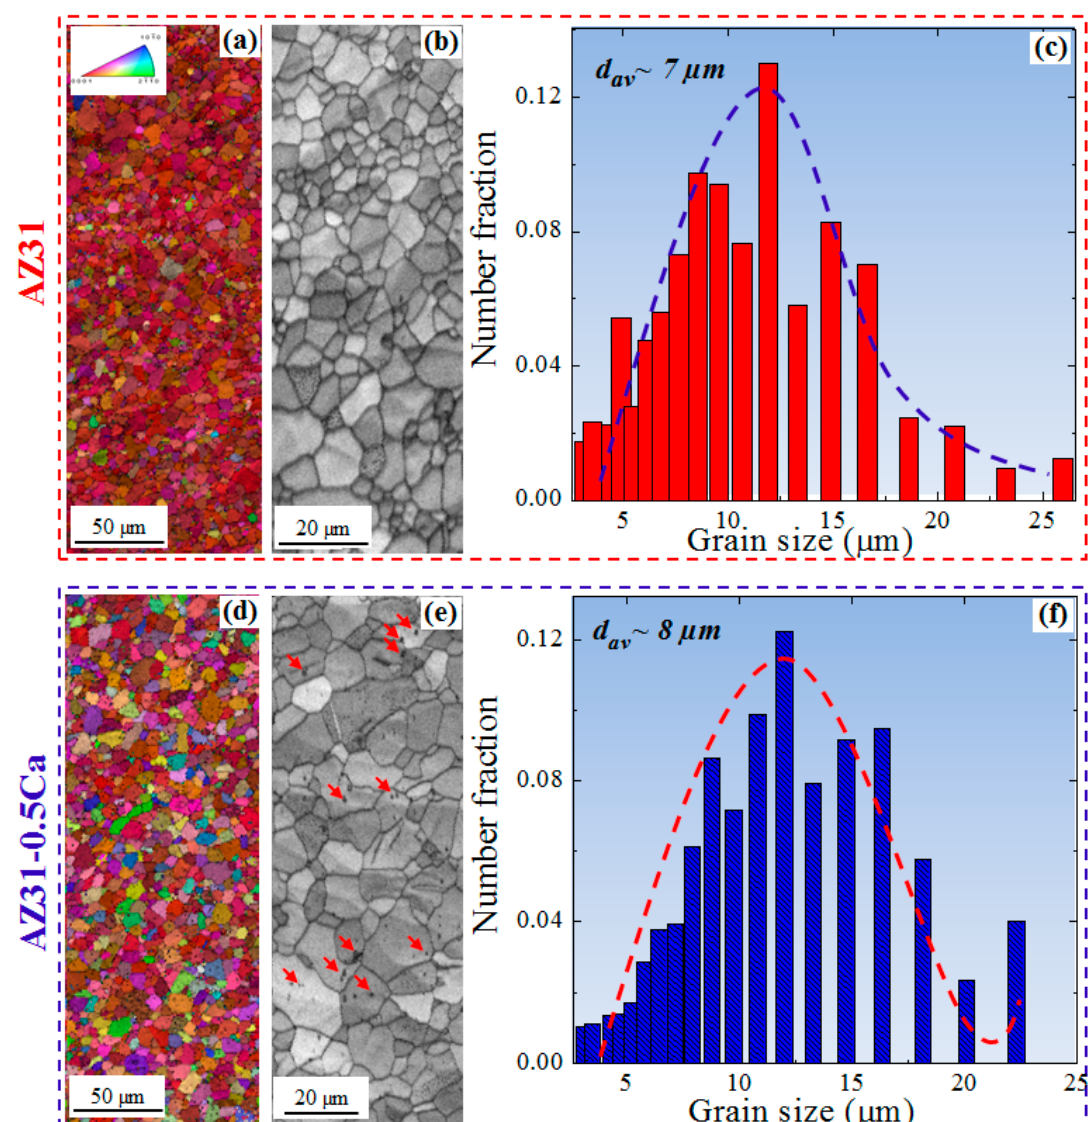
Figure 2. ( a , d ) ND inverse pole figure maps; ( b , e ) image quality maps; and ( c , f ) grain size distributions of the AZ31 and AZ31-0.5Ca alloys, respectively. The grain size measurements by EBSD experiment were conducted at a tolerance angle of 2°.